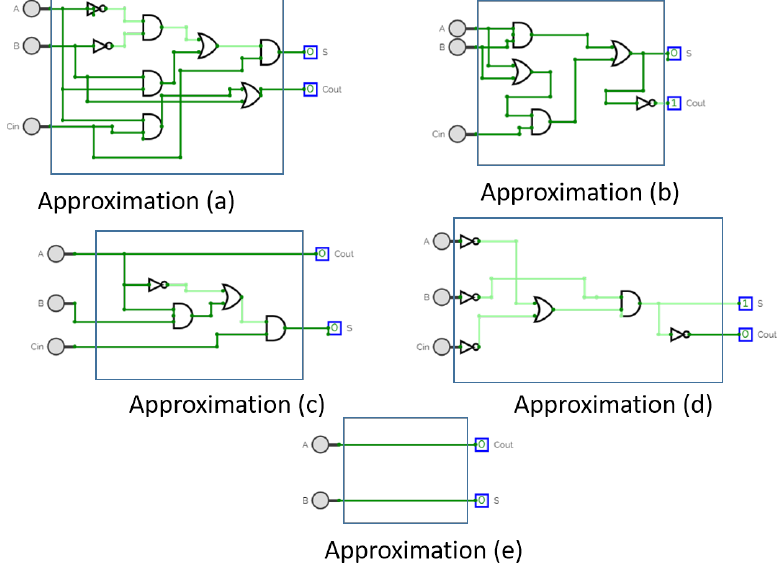
Figure 5. Approximate adders used in [38]. ( a ) Full-adder, ( b ) the carry-out and the sum are com- plemented, ( c ) the input A is copied to the carry-out, ( d ) both sum and carry-out are approximated, ( e ) the input A is copied to sum and B is copied to